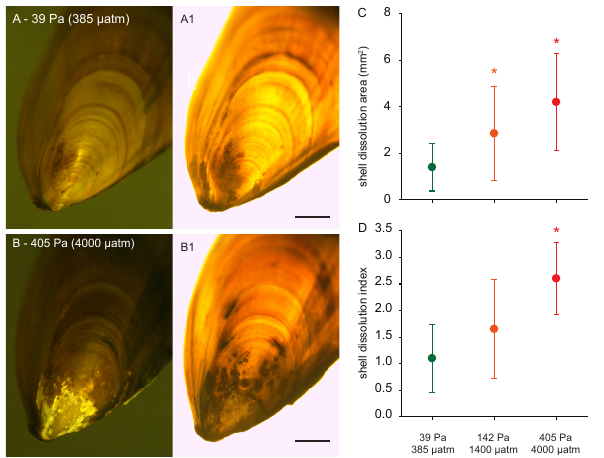
Fig. 5. External shell dissolution at the umbo region. Images of umbones of medium sized shells taken under reflected (A, B) and transmitted (A1, B1) illumination to quantify shell dissolution area and the severity. In B1, dissolution spots are visible as darker re- gions, as corroded shell material blocks the light more than intact crystal structures. (A, A1) 39Pa (385µatm), dissolution index = 1, (B, B1) 405Pa (4000µatm), dissolution index = 3; scale bars = 2.5mm. (C) shell dissolution area at the umbo region (mm 2 ) of medium sized mussels, (D) shell dissolution index; N = 20 mussels randomly chosen from the 4 replicate treatments, asterisks indicate significant differences from control (39Pa, 385µatm) using Dunn’s test. See Table S1 (Supplement) for the Kruskal-Wallis tests.